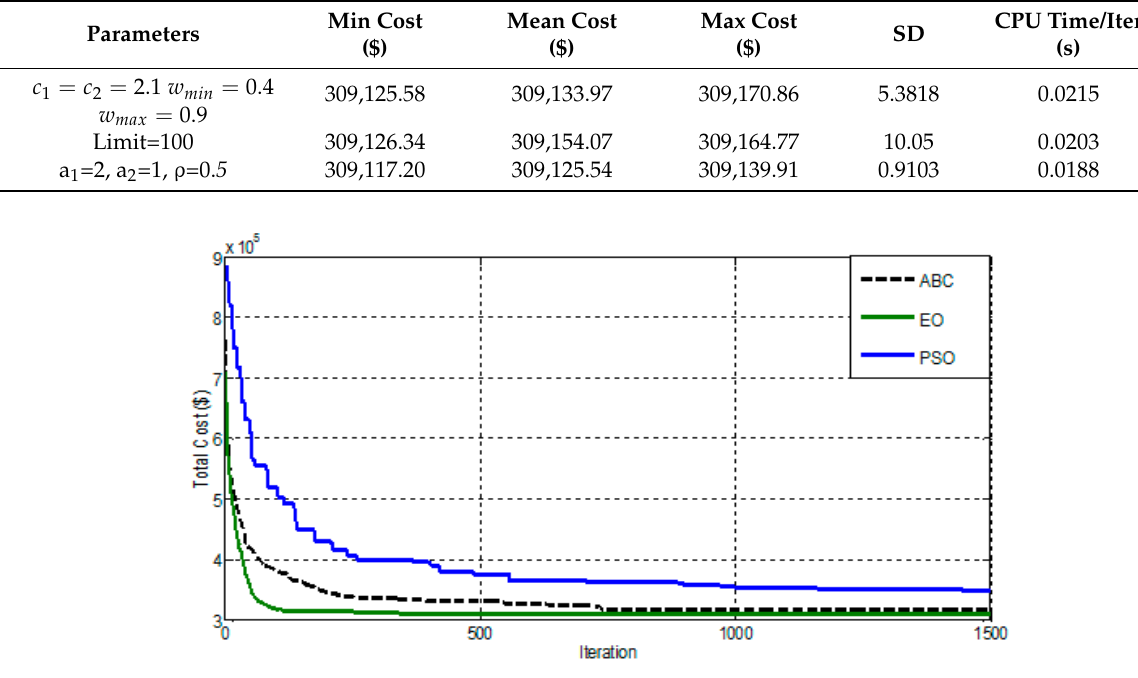
Figure 7. Cost Convergence curve of ABC, PSO and EO for test case 1.